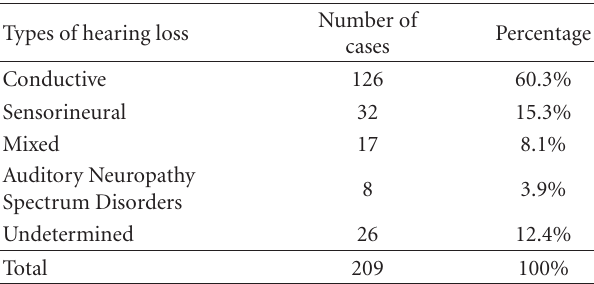
Table 4: A list of medical conditions events contributing to